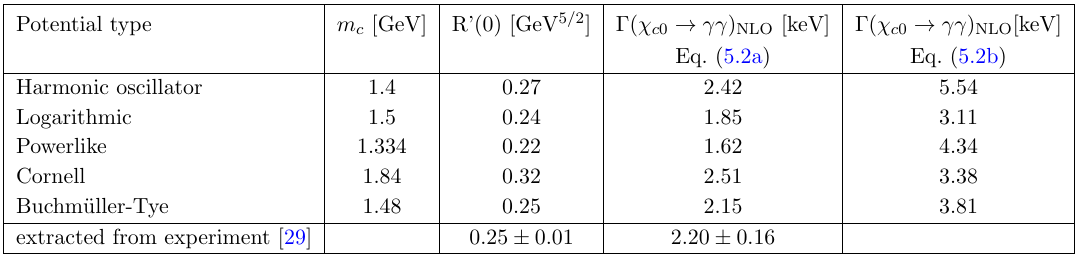
Table 6 . (cid:0)( (cid:31) c 0 ! (cid:13)(cid:13) ) NLO according to eqs. (5.1), (5.2) with respect of quark mass for distinguished potential. R 0 (0) is obtained from eq. (3.18).